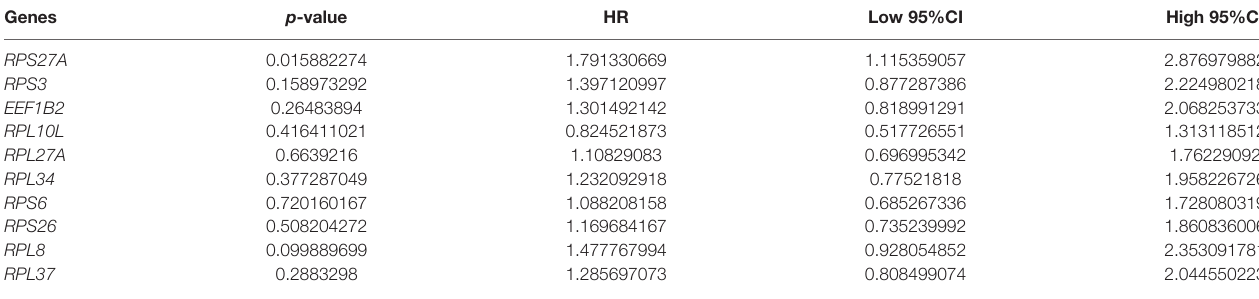
TABLE 1 | Summary of the Kaplan – Meier curve data for the 10 key genes. Genes p -value